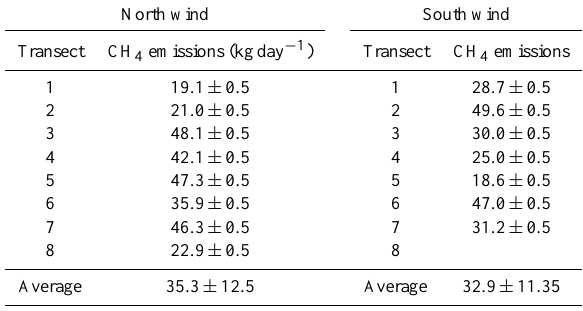
Table 3. CH 4 emissions (kgday − 1 ) for the whole station using the tracer release method.